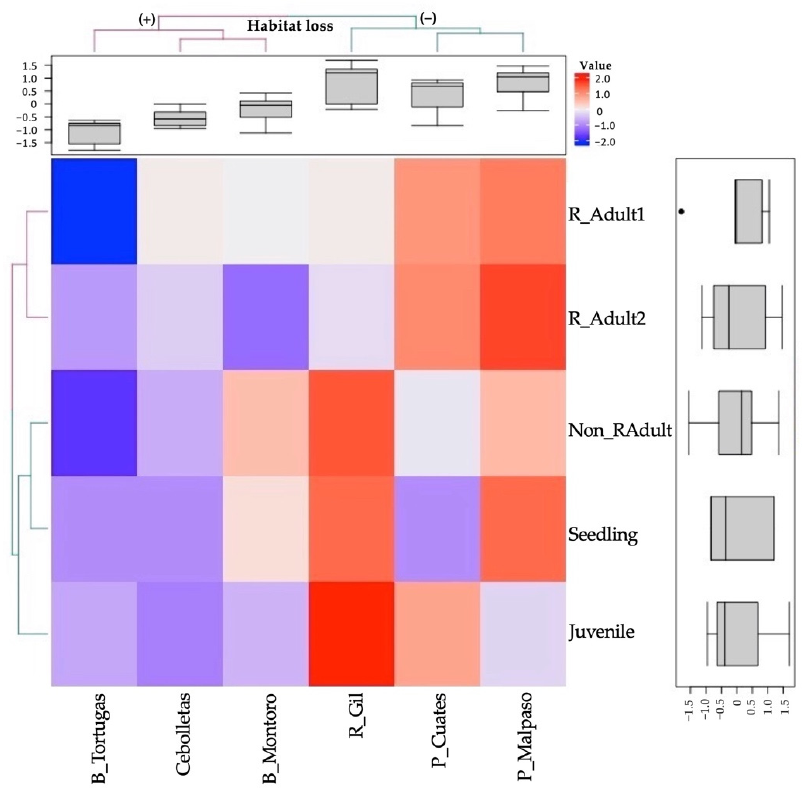
Figure 4. Heatmap based on the normalized abundance value of the size categories (in rows, Seedling, Juvenile, Non_RAdult: non-reproductive adult, R_Adult1: reproductive adults (1) and R_Adult2: reproductive adults (2)) of the analyzed sites (in columns, B_Tortugas: Barranca Tortugas, Cebolletas: Presa Cebolletas, B_Montoro: Barranca Montoro, R_Gil: Río Gil, P_Cuates: Puente Cuates and P_Malpaso: Presa Malpaso). The red color means the maximum correlation value and decreases towards the blue color. Populations with high (+) and low ( − ) levels of habitat loss.